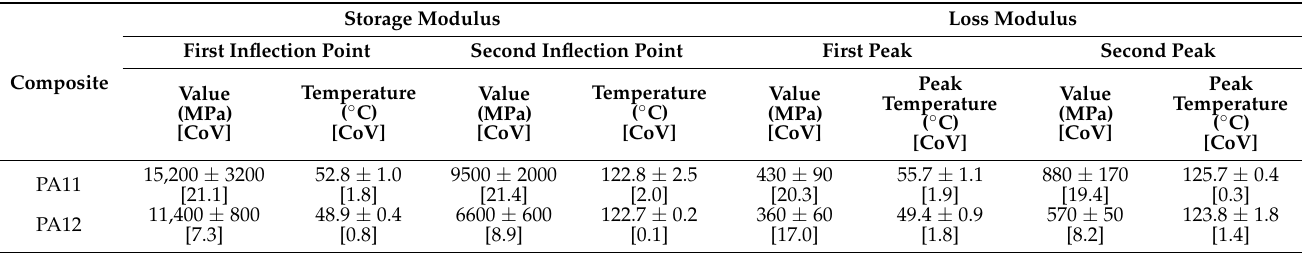
Table 7. Inflection points for storage modulus and peak values for loss modulus for composites and their associated temperatures, considering two interesting inflection points and